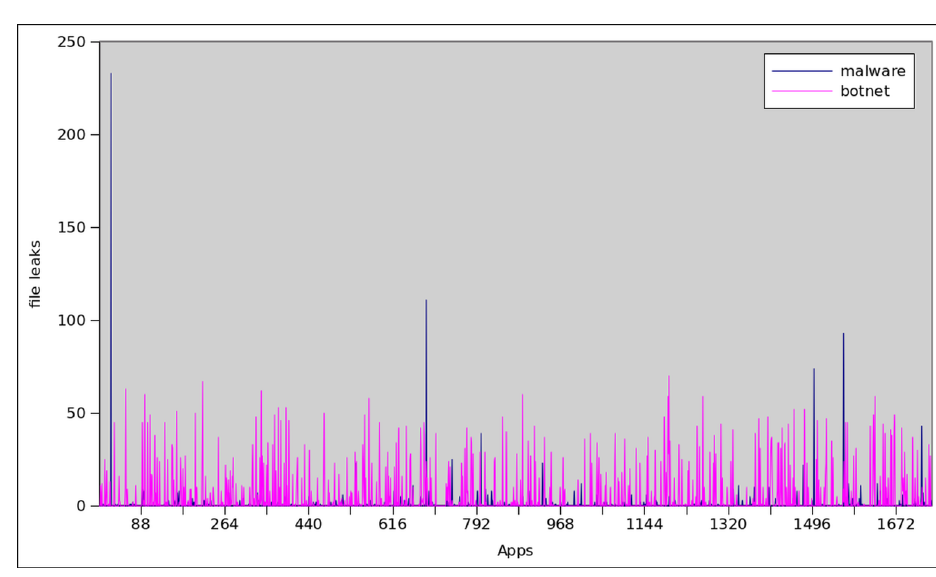
Fig 23. File Leak statistics among all Botnet and Malware.